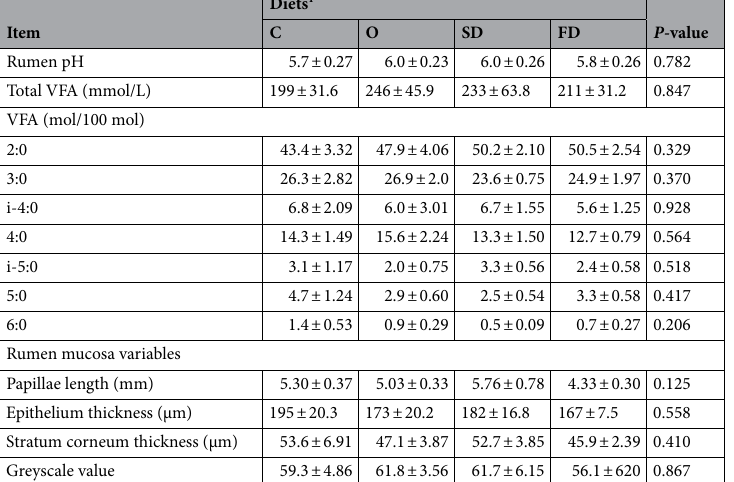
Table 3. Rumen pH, volatile fatty acid (VFA) concentration and molar proportion, and mucosa variables of lambs fed experimental diets. Values are means ± standard error of the mean. 1 Diets: C, control; O, Control